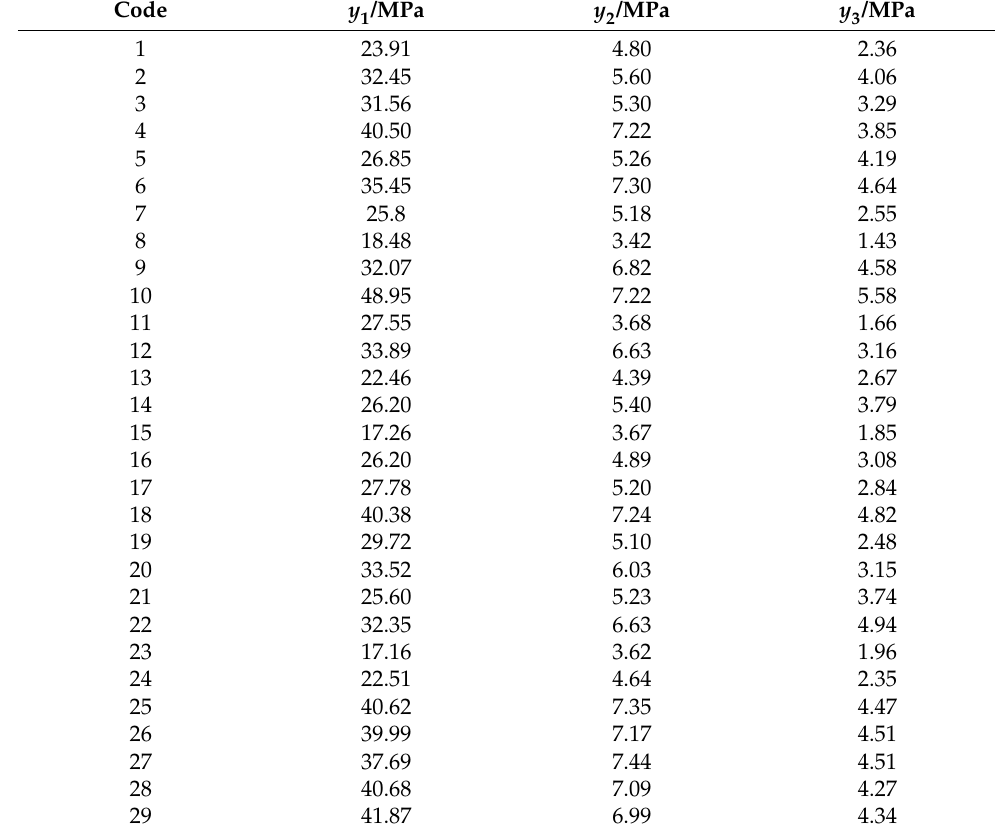
Table 6. RSM test results.